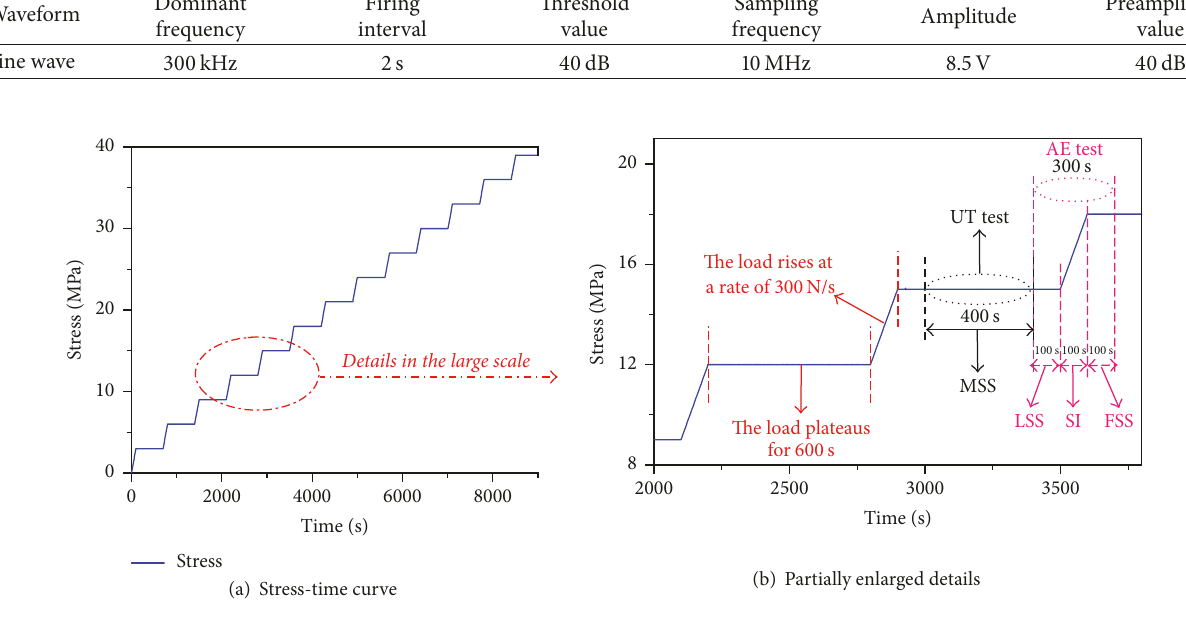
Figure 3: The step-loading path of concrete and experimental test